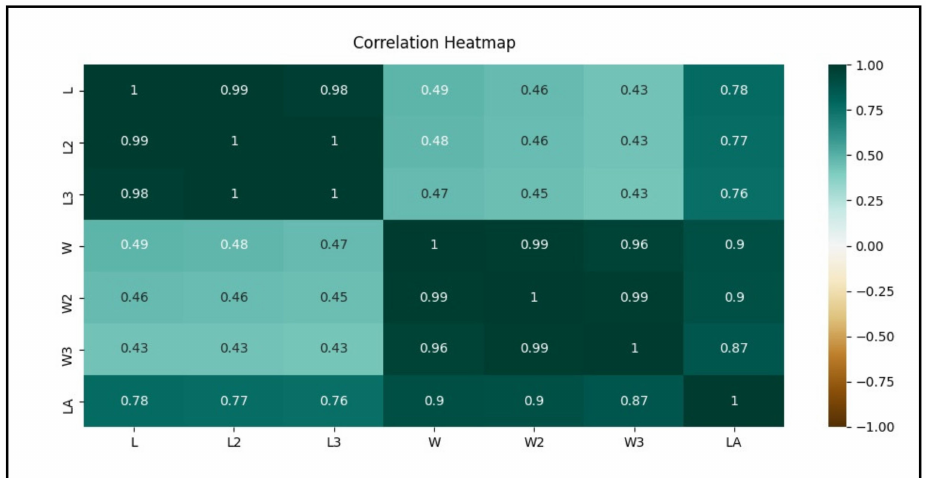
Figure 4. Correlation heatmap illustrating the relationship between each variable and compared